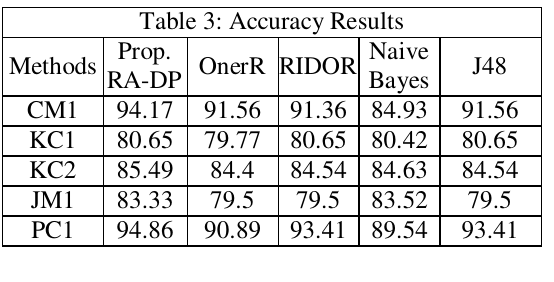
Table 4: Sensitivity Results Prop. RA- Methods DP